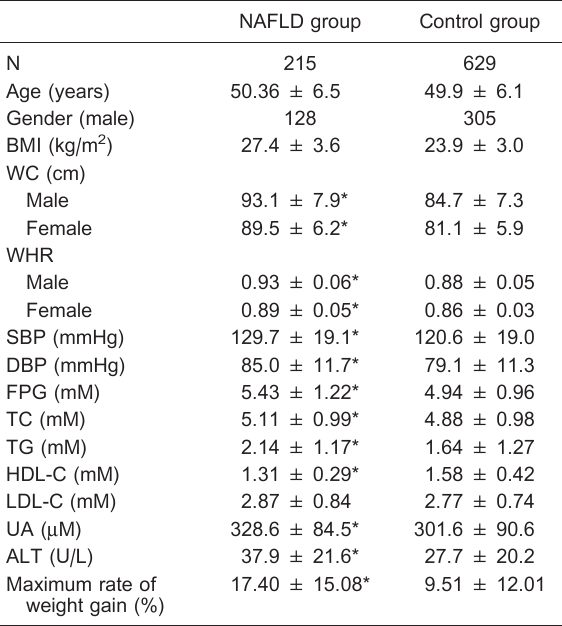
Table 1. Clinical characteristics of the study subjects. NAFLD group Control